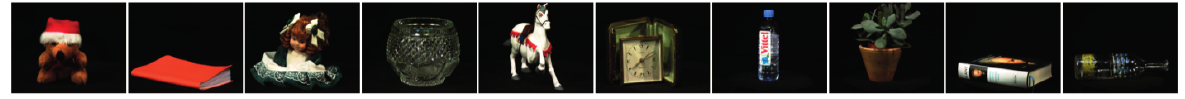
Figure 7. Samples of images from the Amsterdam Library of Images (ALOI) database.